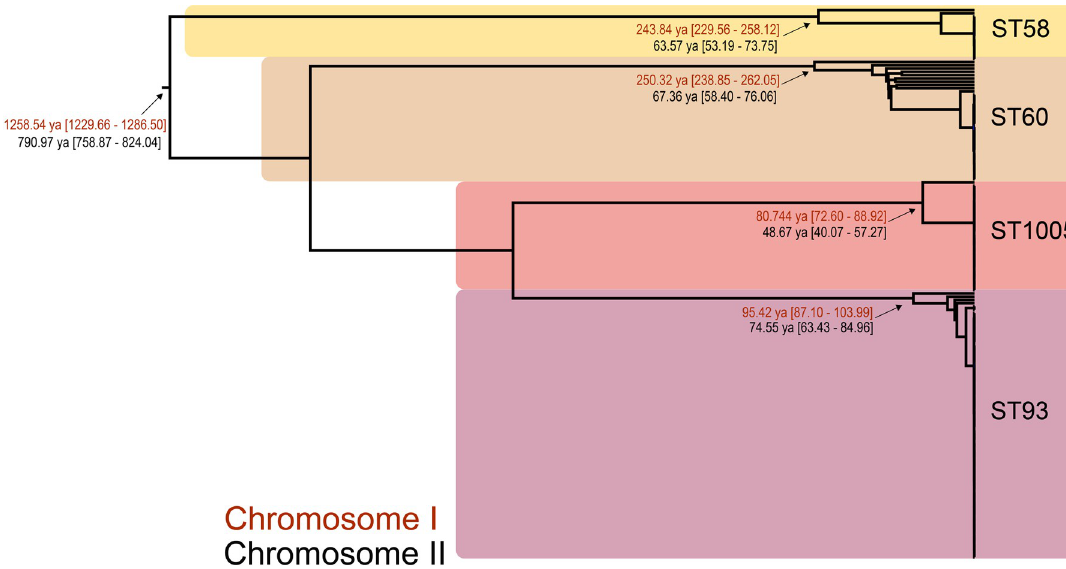
Fig 4. Estimate of times to most recent common ancestor for the 169 INT2 B . pseudomallei genomes using BEAST [56]. Node dating ranges for both chromosomes (chromosome I in red, chromosome II in black) are shown on the Bayesian phylogeny. STs are indicated for each